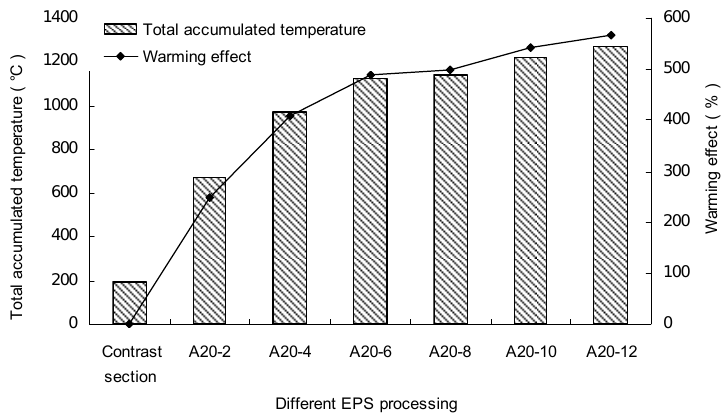
Figure 4. Total accumulated temperature and warming effects of the EPS with different thicknesses.